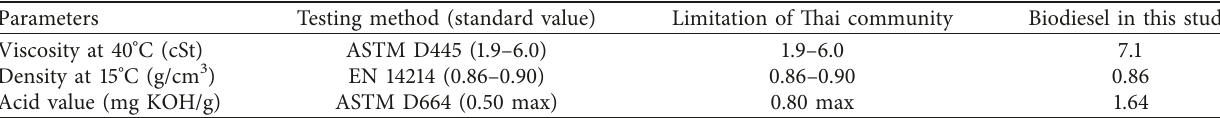
Figure 6: RPO conversion: (a) effect of % wt. catalyst, (b) effect of MeOH :oil molar ratio, and (c) effect of reaction time. Table 2: Properties of RPO